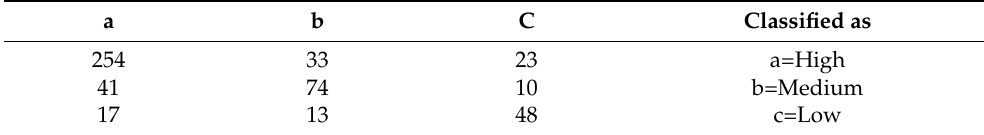
Table 2. Confusion matrix obtained for Naïve Bayes.